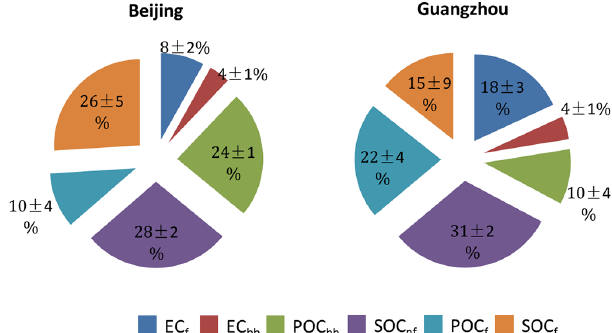
Figure 2. Correlations between the primary biomass burning OC (POC bb ) and the non-fossil secondary organic carbon (SOC nf ) . Figure 3. Relative contributions (%) of different carbon species